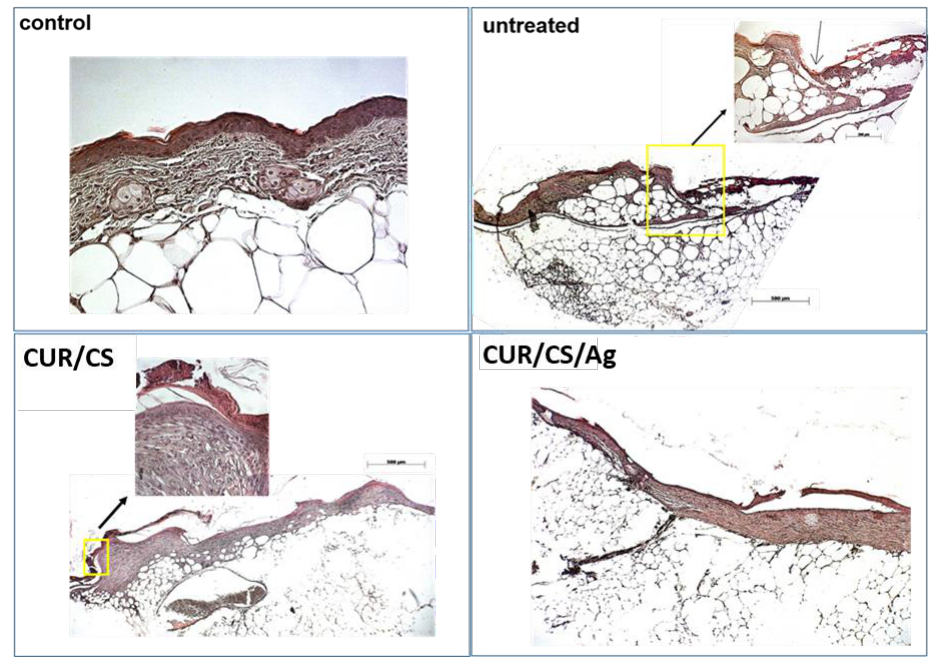
Figure 11. Histology analysis of a full-thickness cutaneous defect after treatment with membranes. Yellow squares enclose the edge of the wound. Red arrows indicate infiltrating inflammatory cells (polymorphonuclear lymphocytes; number of animals in each group of dressings, n = 3).